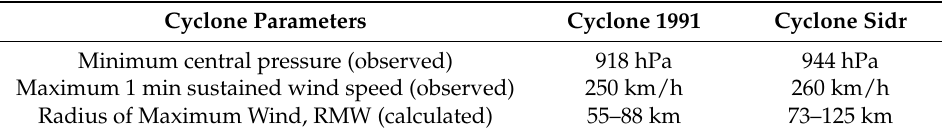
Table 1. Cyclone parameters of the two previous cyclone events considered as base